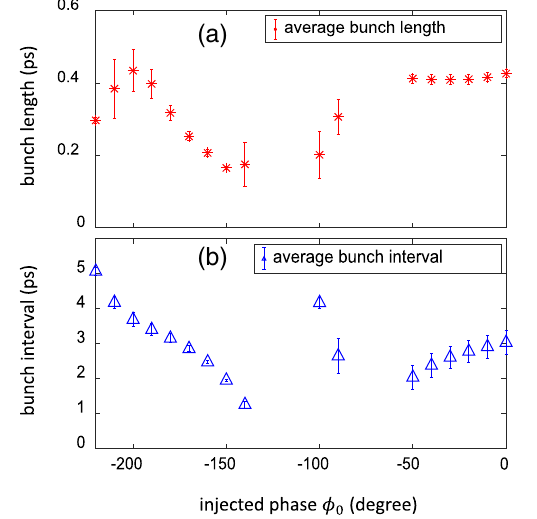
FIG. 10. Bunch lengths and bunch intervals with different injected phases ϕ 0 for a 4 × 20 pC bunch train; (a) and (b) correspond to the statistics parameters in Tables II and III, respectively.